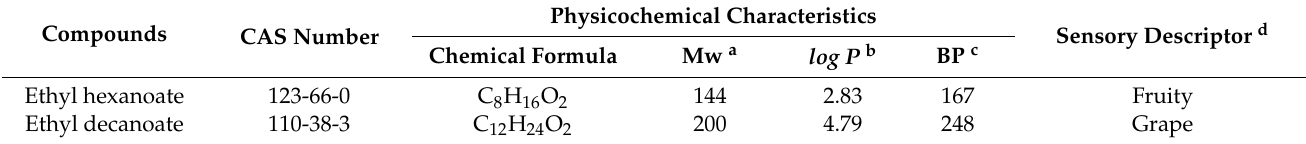
Table 1. Characteristics of the esters added to the